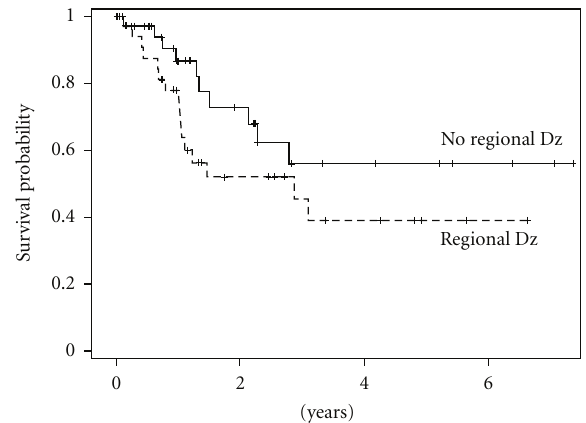
Figure 2: Disease-free survival for patients with and without positive nodal metastasis.Two-year disease-free survival for patients with regional disease was 47.7% versus 72.9% for those without regional metastasis ( P = .